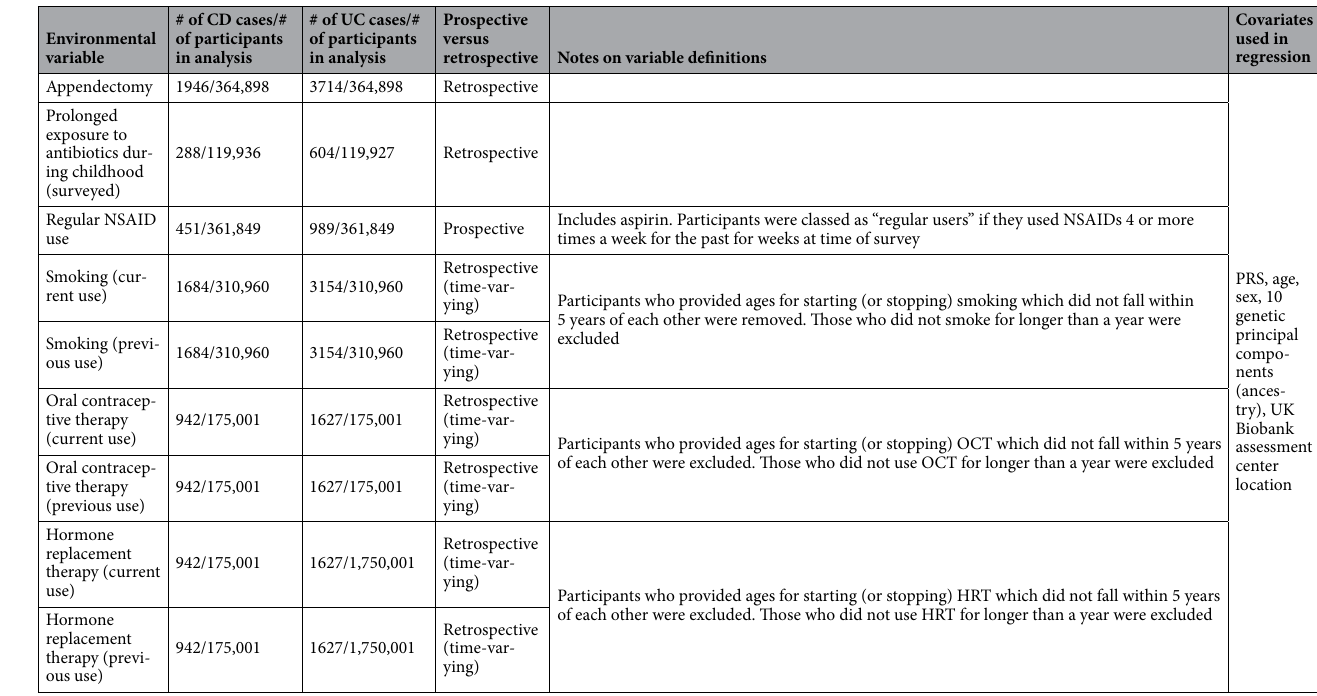
Table 1. Characteristics of environmental variables investigated. PRS = polygenic risk score. OCT = oral contraceptive therapy. HRT = hormone replacement